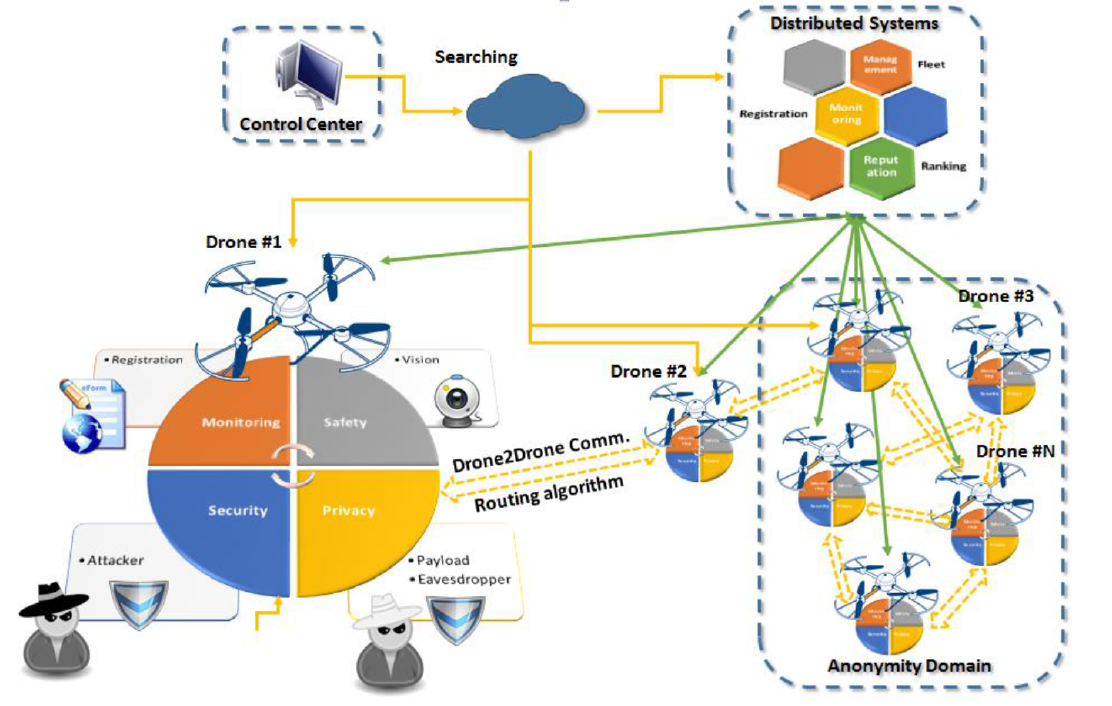
Figure 4. Proposed UAV IoT